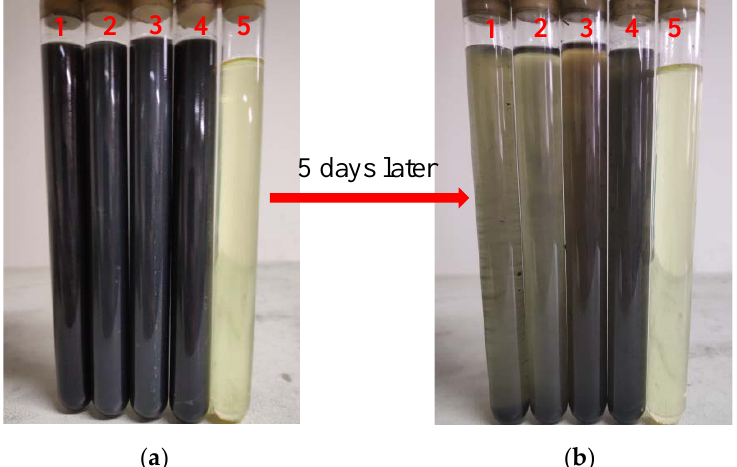
Figure 6. Dispersion of additives ( a ) freshly prepared and ( b ) sealed for 5 days within ( 1 ) 500SN + 0.5